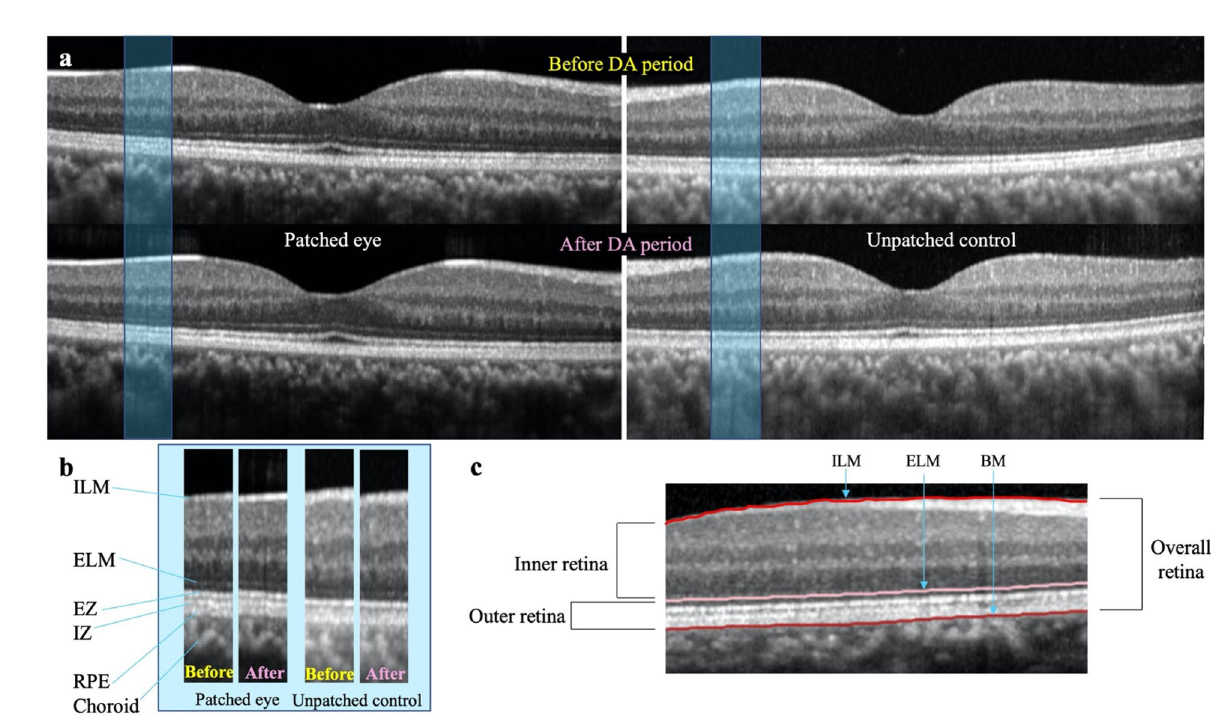
Figure 3. Example of Spectral Domain Optical Coherence Tomography (SD OCT) retinal images obtained ( A ) B-scan of one subject’s retina through the fovea in the dark adapted/patched eye (left) and unpatched control eye (right), before and after the dark adaptation (DA) period. ( B ) Side-by-side comparison of the OCT images for the same local retinal region (outlined by the blue rectangles in [ A ]) for patched and unpatched eyes, before and after the DA period. ILM internal limiting membrane, ELM external limiting membrane, EZ ellipsoid zone, IZ interdigitation zone, RPE retinal pigment epithelium ( C ) Example of the segmentation performed by the Heidelberg Spectralis software that was used to generate thickness maps for the outer retinal layer. BM basement